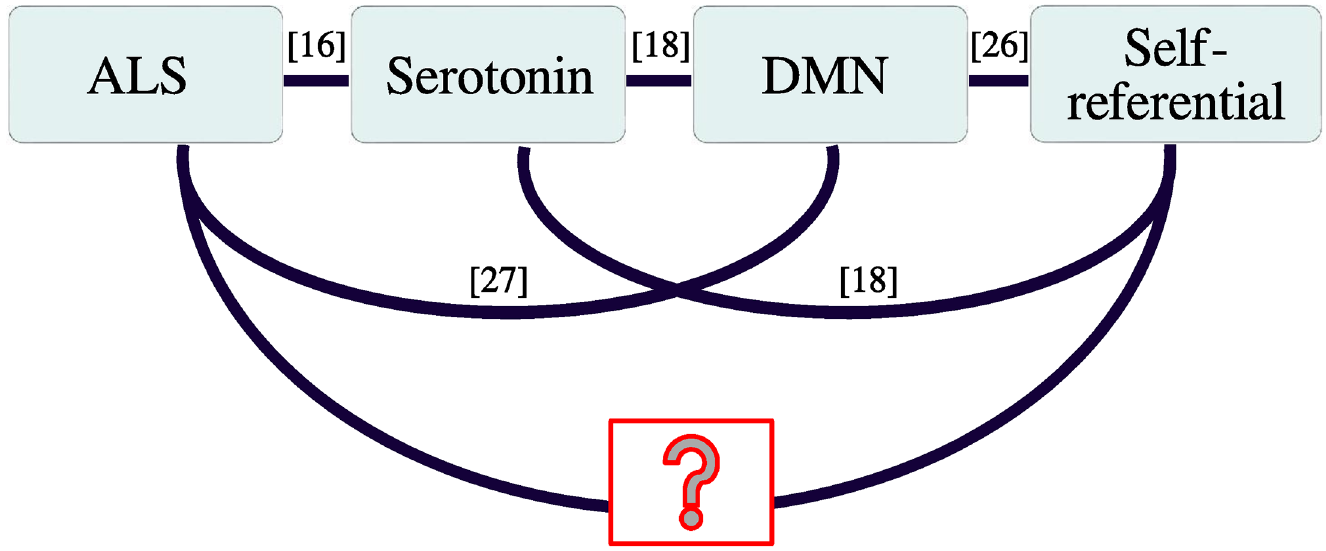
Fig 1. Motivation. Overview of the studies relatingALS and self-referential